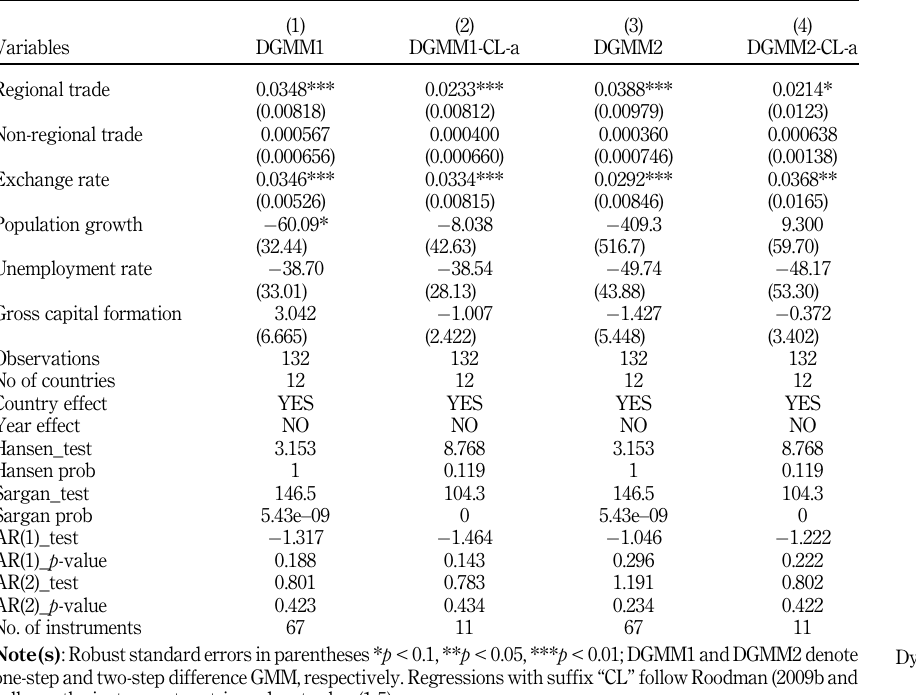
analyses- difference